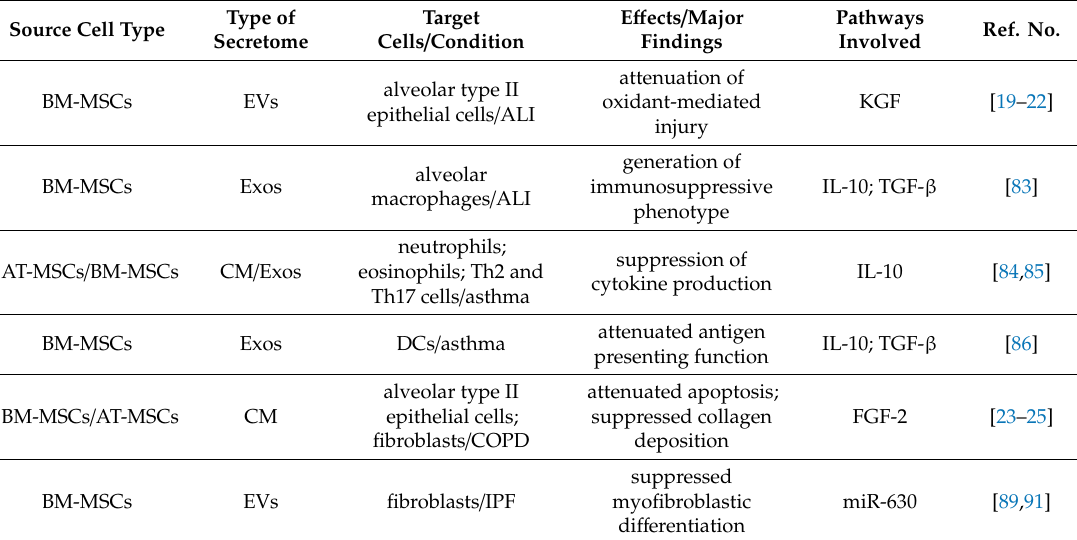
Table 2. MSC-sourced secretome in the therapy of lung